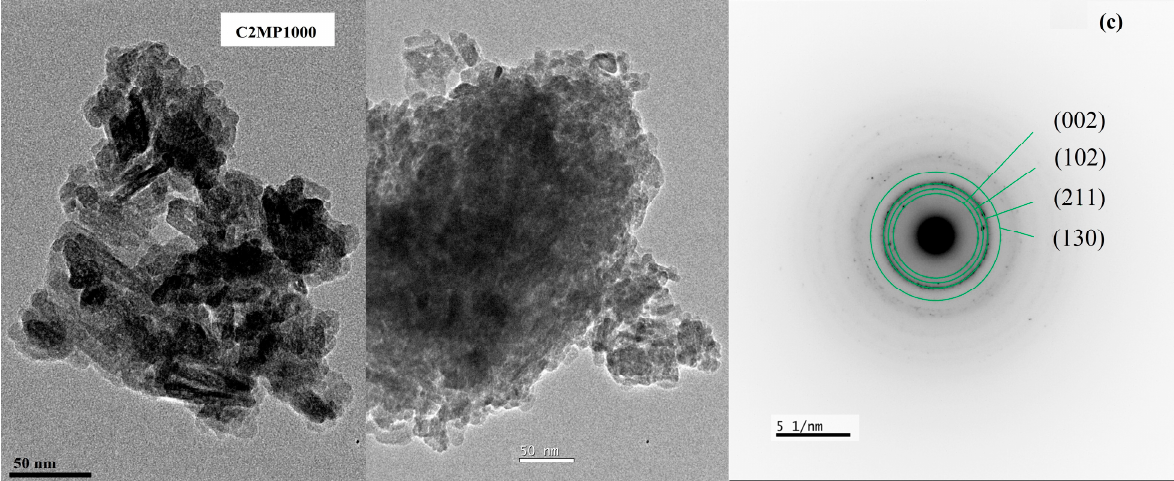
Figure 6. Morphology and SAED of hydroxyapatite nanoparticles in C1MP850 ( a ), C1MP1000 ( b ), C2MP1000 ( c ) observed using TEM.